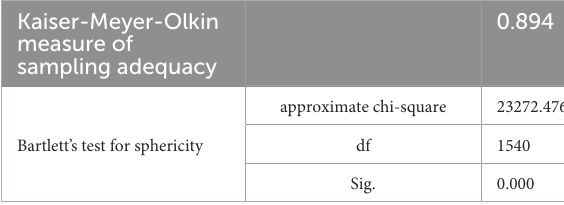
TABLE 3c Variable convergent validity